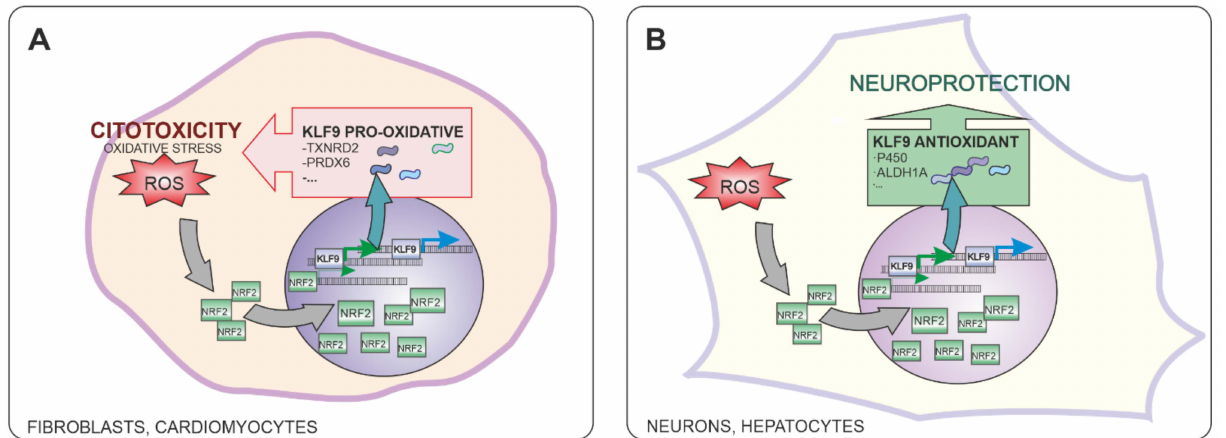
Figure 5. Kruppel-Like Factor 9 (KLF9) transcription factor is expressed as a consequence of excessive NRF2 activation. KLF9 has been shown to have different effects in different cell types: While in some cells, KLF9-mediated gene expression results in increased ROS production and cytotoxicity ( A ), KLF9 has been shown to reduce oxidative stress and promote neuroprotection in neurons and hepatocytes ( B